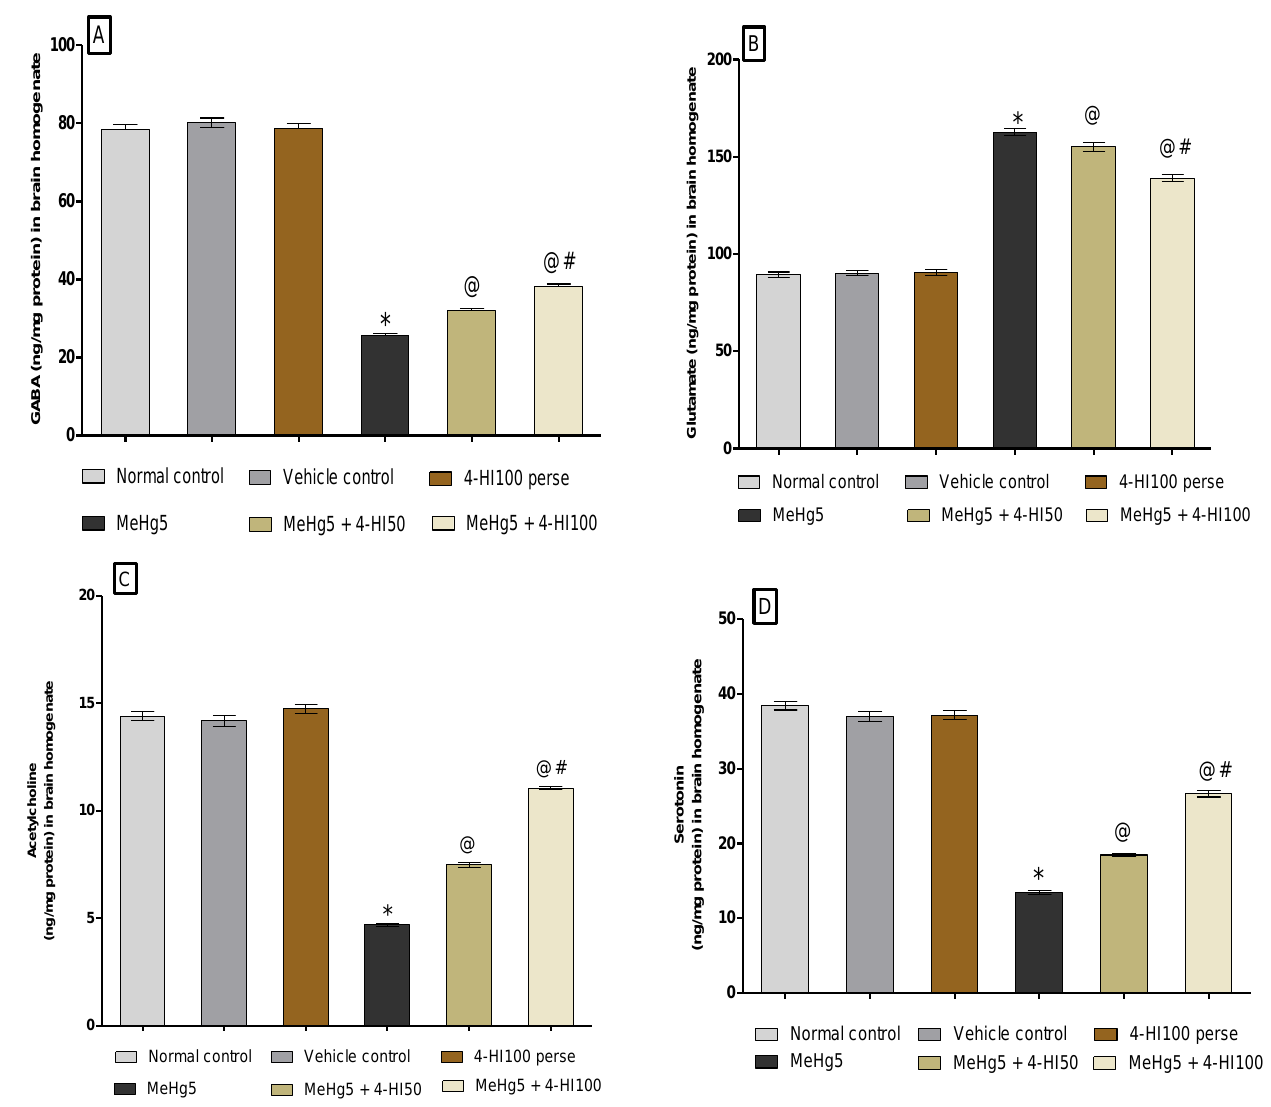
Figure 12. Effect of 4-hydroxyisoleucine on neurotransmitters after methyl mercuryexposure in rats ( A – D ).Statistical analysis by one- way ANOVA (posthoc Tukey’s test). Values are expressed as mean ± SEM ( n =6 rats per group). * p <0.001 v/s normal control, vehicle control and 4-HI100 perse ; @ p <0.001 v/s MeHg5; @# p <0.001 v/s MeHg5 + 4-HI50.